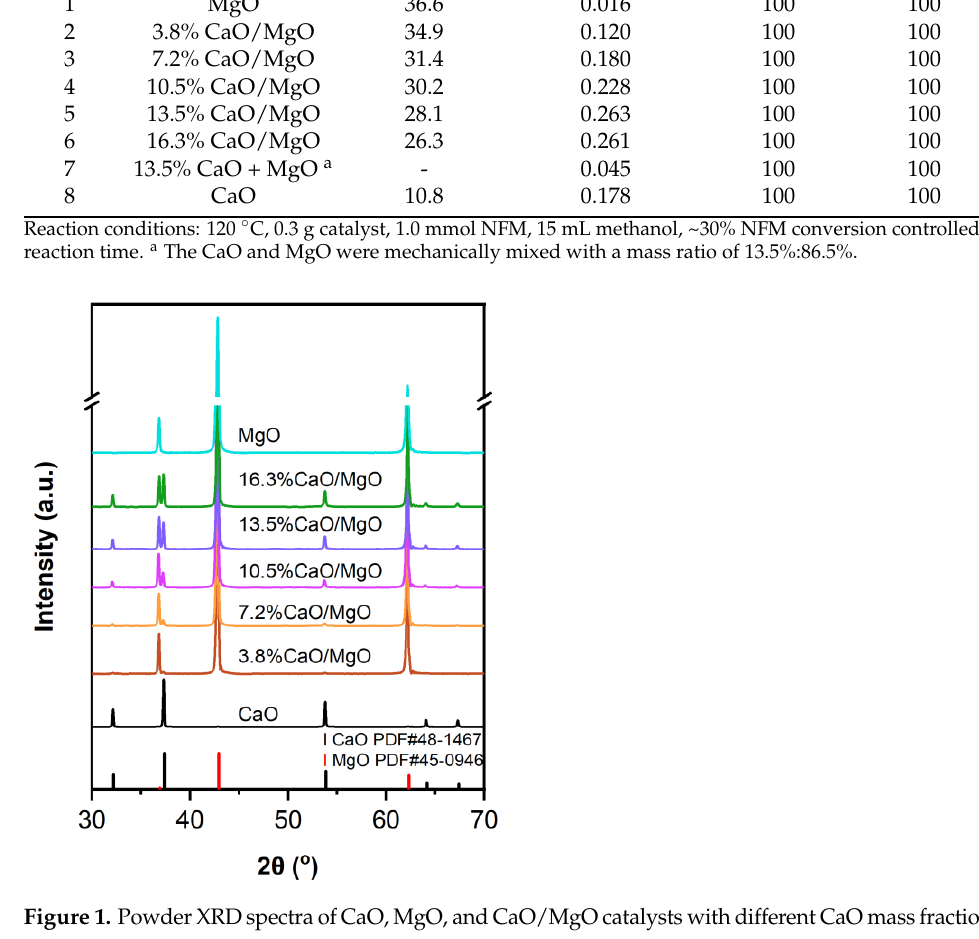
Table 2. Alcoholysis rate of NFM and product selectivities over different CaO/MgO catalysts.